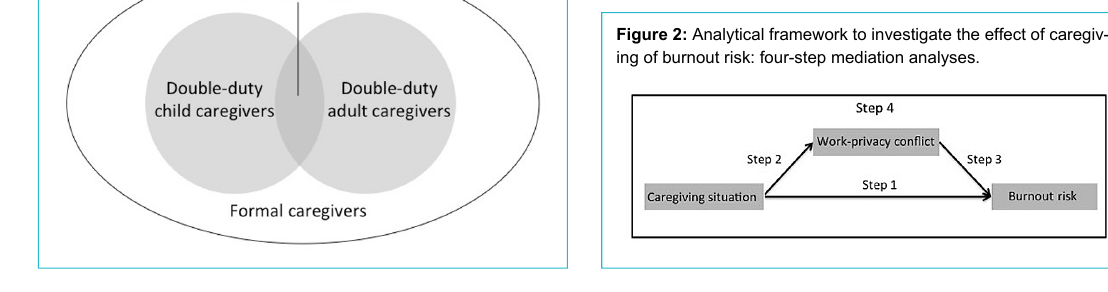
Figure 2: Analytical framework to investigate the effect of caregiv- ing of burnout risk: four-step mediation